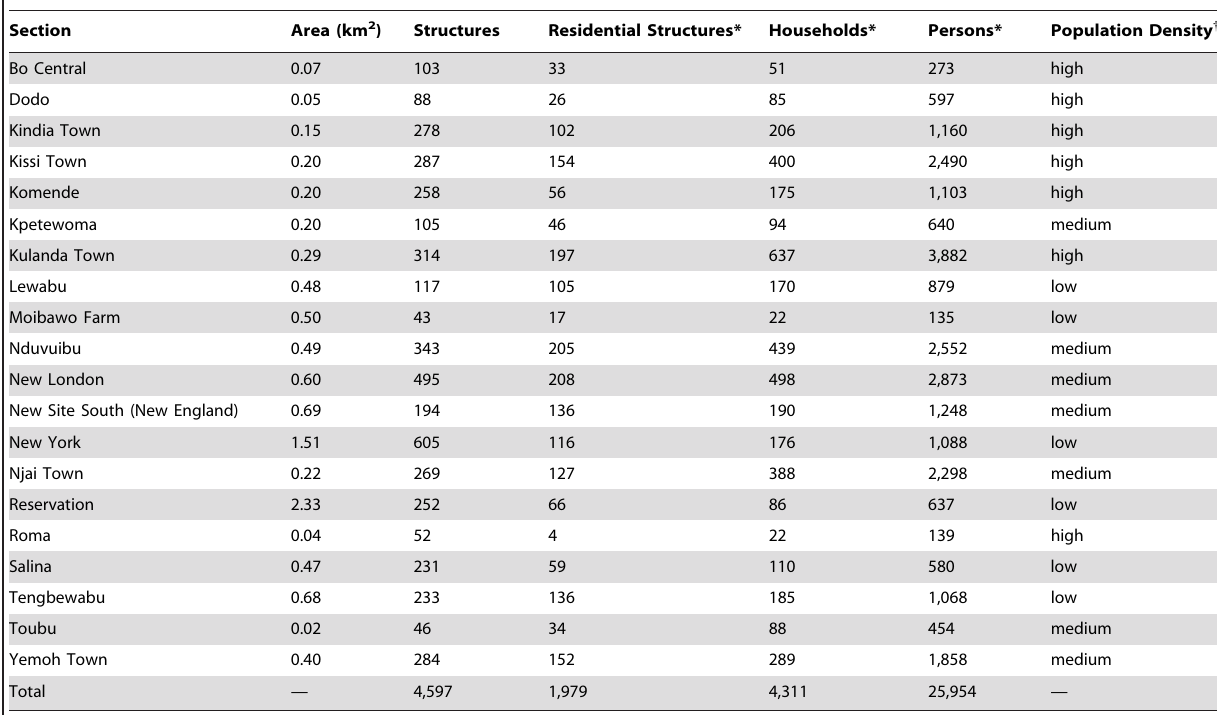
Table 1. Summary of survey data for 20 sections of Bo.